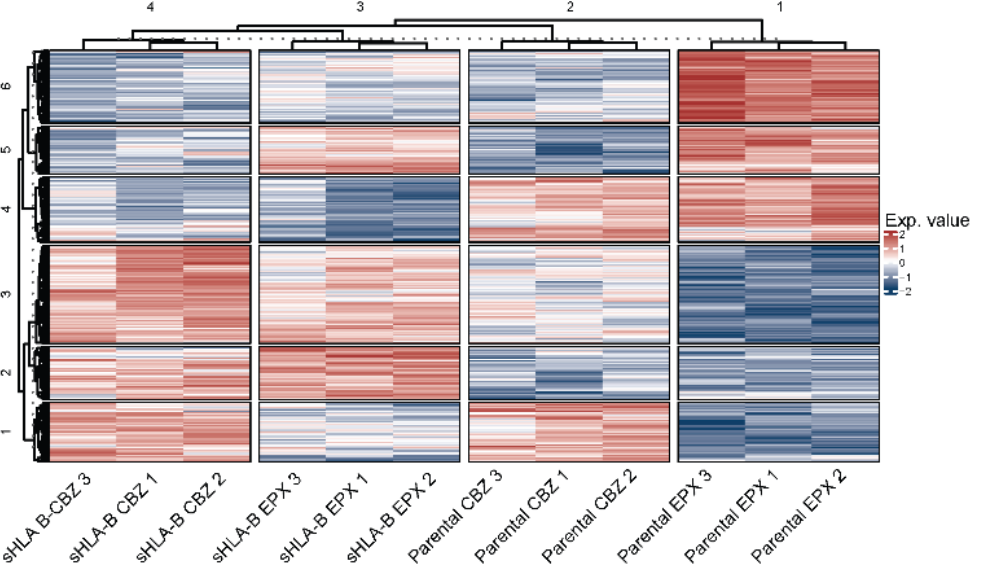
Figure 2. Proteome analysis LCL721.221/sHLA-B*57:01 cells or parental LCL721.221 cells treated with either CBZ or EPX. Heat map of proteins significantly changed ( p < 0.05) after FDR-based ANOVA testing.